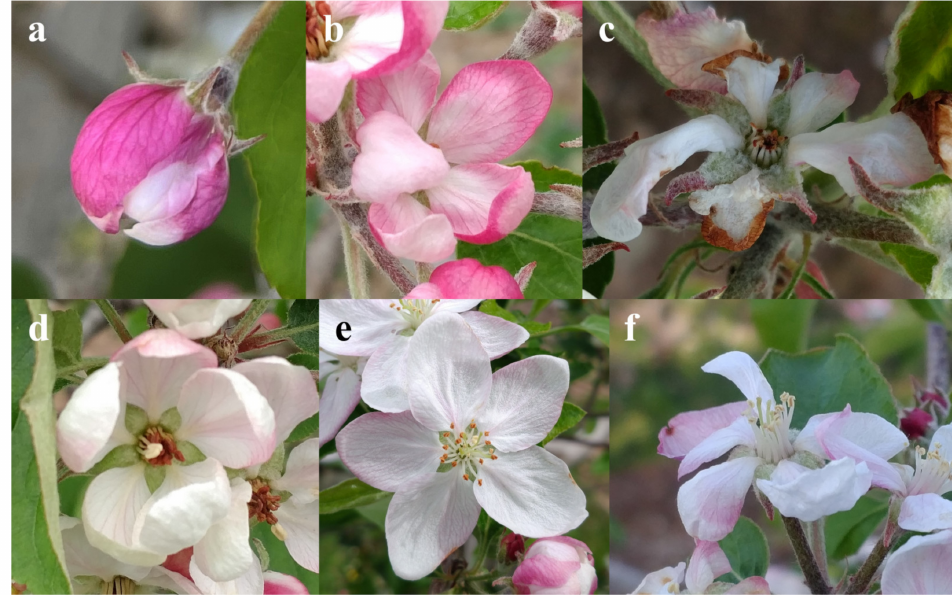
Figure 3. Examples of apple flowers that were excluded (first row) or included (second row) during the manual blossom counting: ( a ) an unopened blossom with pink petals; ( b ) a half-opened blossom with pinkish petals; ( c ) a wilted and shrunken blossom; ( d ) a half-opened blossom with white petals; ( e ) a fully opened white blossom; ( f ) a wilted blossom of substantial